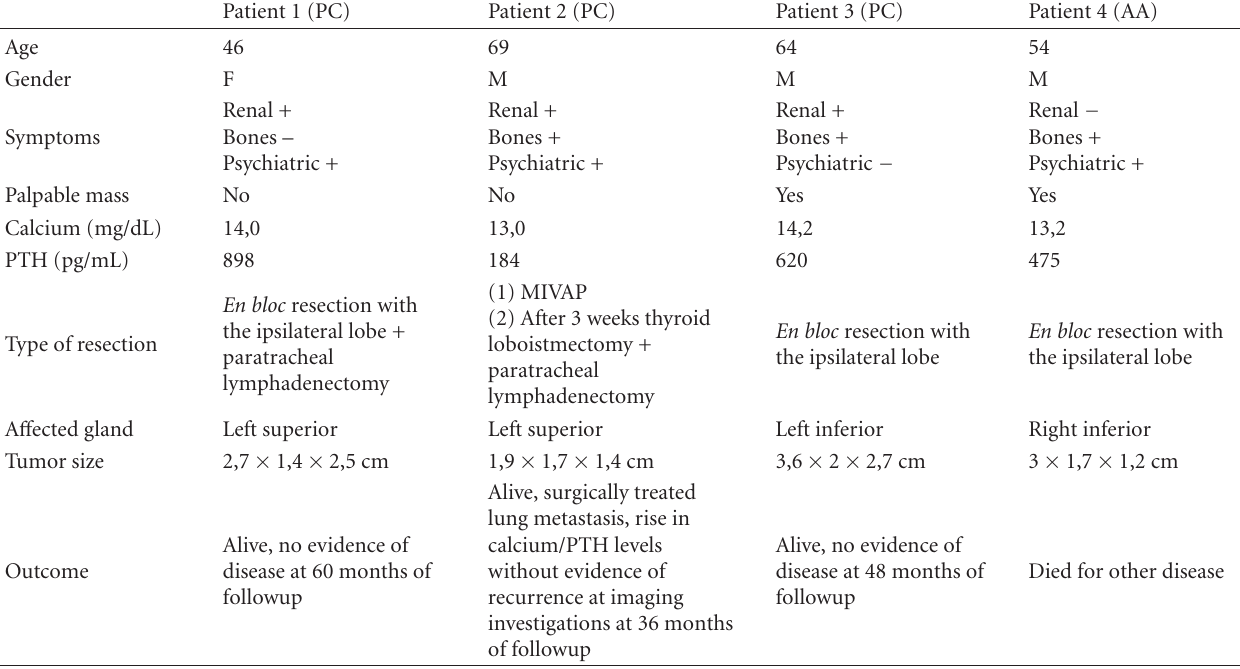
Table 2: Main clinical features of patients with parathyroid carcinoma (PC) and atypical adenoma